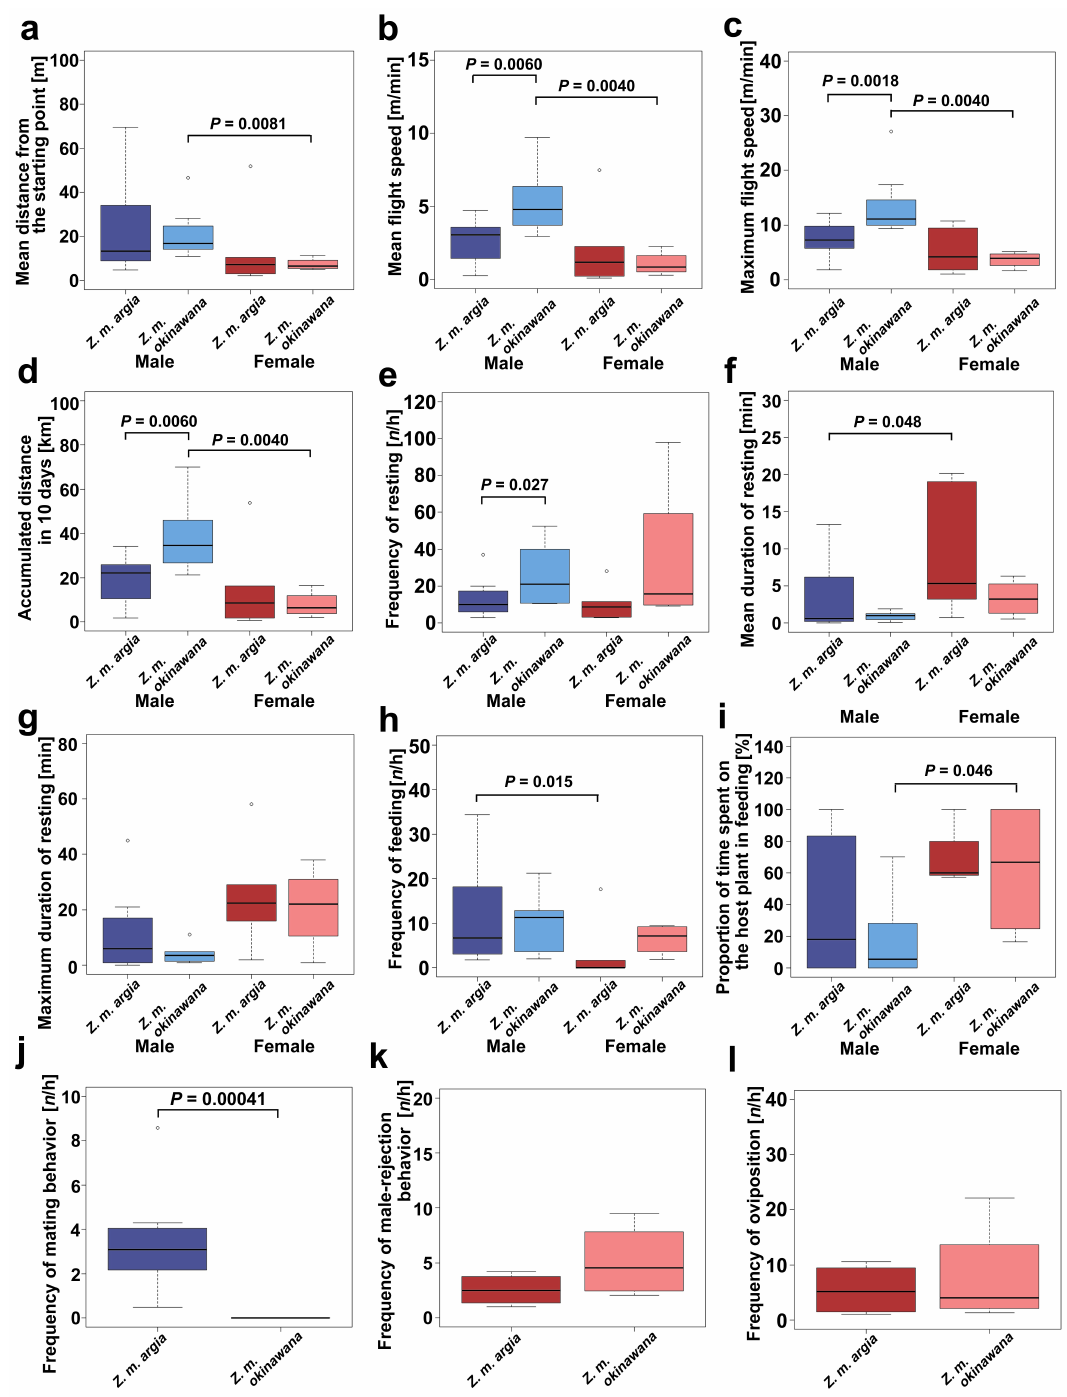
Figure 2. Comparison of 12 behavioral traits between subspecies and between sexes in Z. maha . ( a ) The mean distance from the starting point. ( b ) The mean flight speed. ( c ) The maximum flight speed. ( d ) The accumulated distance in 10 days. ( e ) The frequency of resting. ( f ) The mean resting duration. ( g ) The maximum resting duration. ( h ) The frequency of feeding. ( i ) The proportion of time spent on the host plant in feeding. ( j ) The frequency of mating behavior in males. ( k ) The frequency of male-rejection behavior in females. ( l ) The frequency of